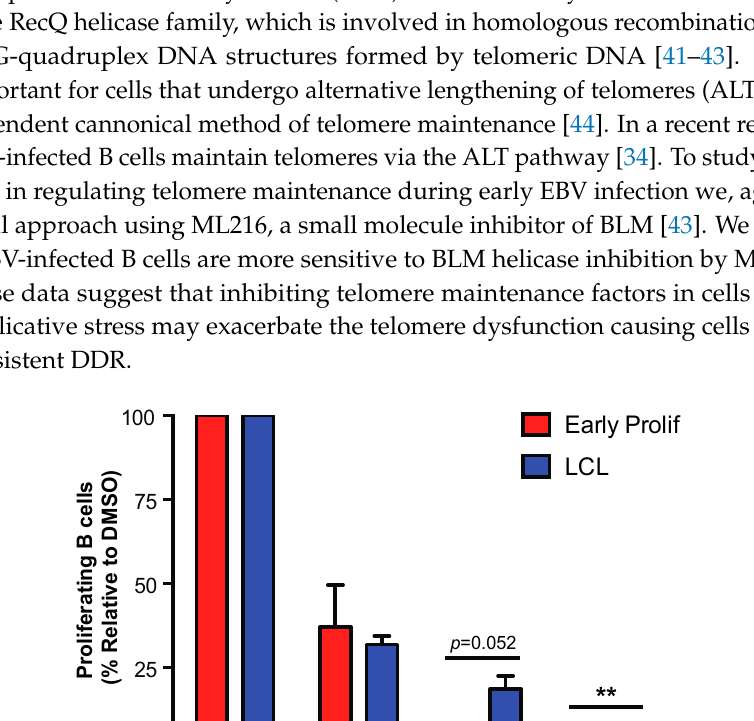
Error bars represent S.E.M of three independent donors. Dotted line represents 62.5% positive wells, which indicates outgrowth from the virus amount in the x -axis of a single LCL per well based on a Poisson’s distribution. ( C , inset ) Fold change of the transformation efficiency. ( D ) Schematic of danazol’s mechanism of action during EBV infection.